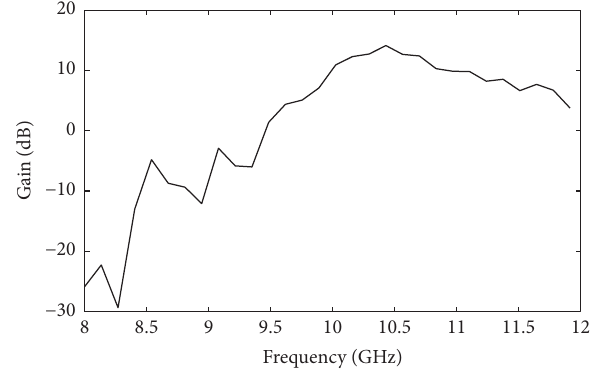
Figure 28: Measured gain pattern versus